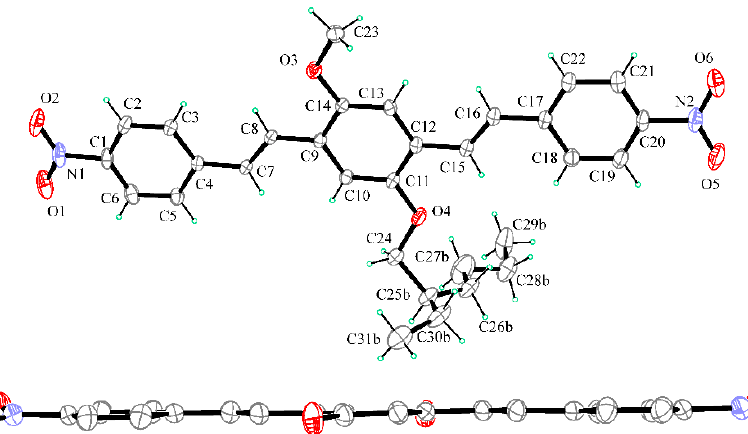
Figure 5. Up: Ortep view of C1 with thermal ellipsoids drawn at 30% probability level. Only major part of the disordered aliphatic group is reported for clarity. Down: perspective view in the edge of C9 / C14 ring (H atoms and alkyl groups at O3 and O4 are not shown for clarity).